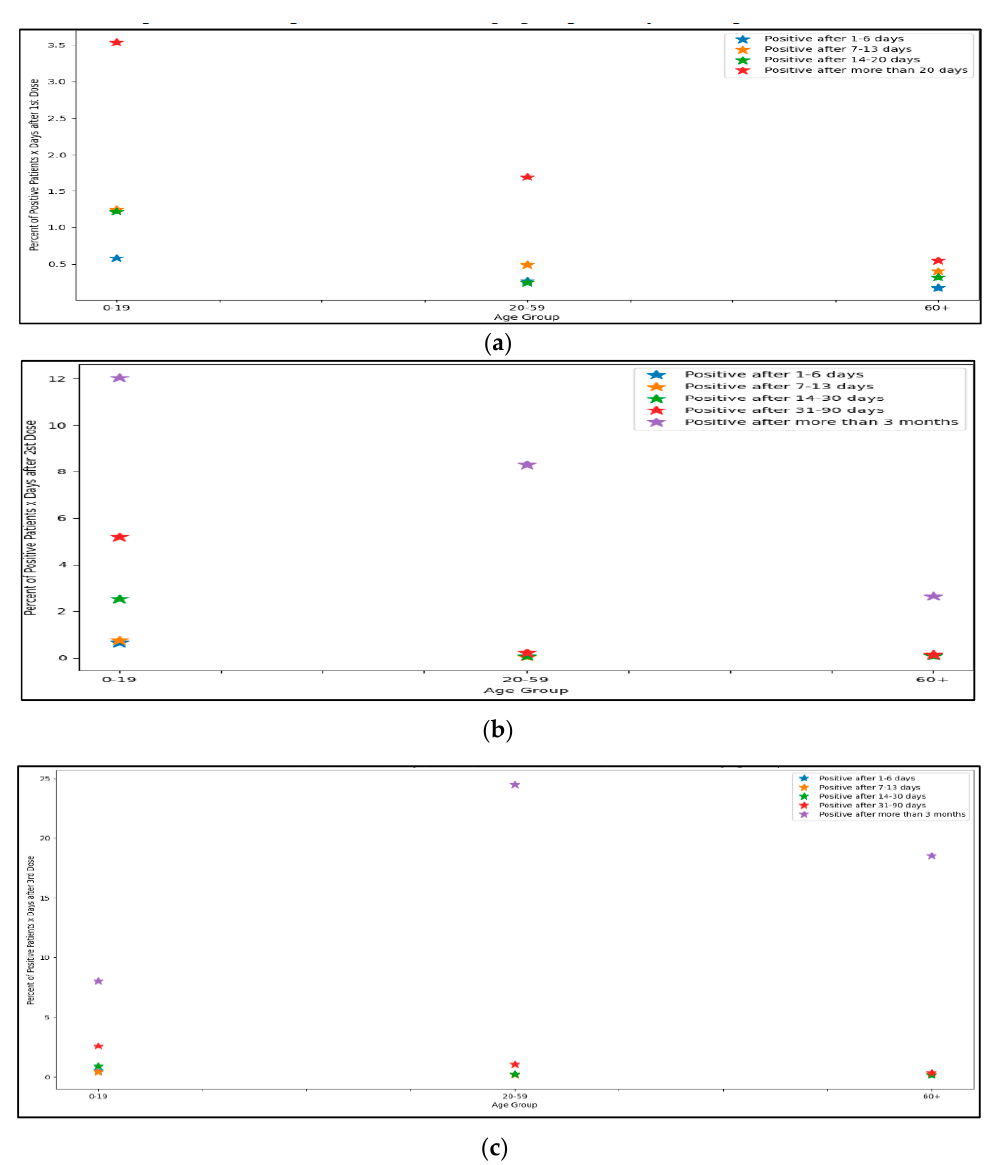
Figure 4. Percentage of positive patients per age group after X (denoted in legend) days after vaccination dose (( a ): first dose; ( b ): second dose; ( c ): third dose). Figure 5, which indicates re-infection, shows that from the beginning of the epidemic until now, the re-infection rate is about 6.22% of all recoverees. This rate is significantly higher among those who are not vaccinated compared to those who have been vaccinated, at least in one dose.